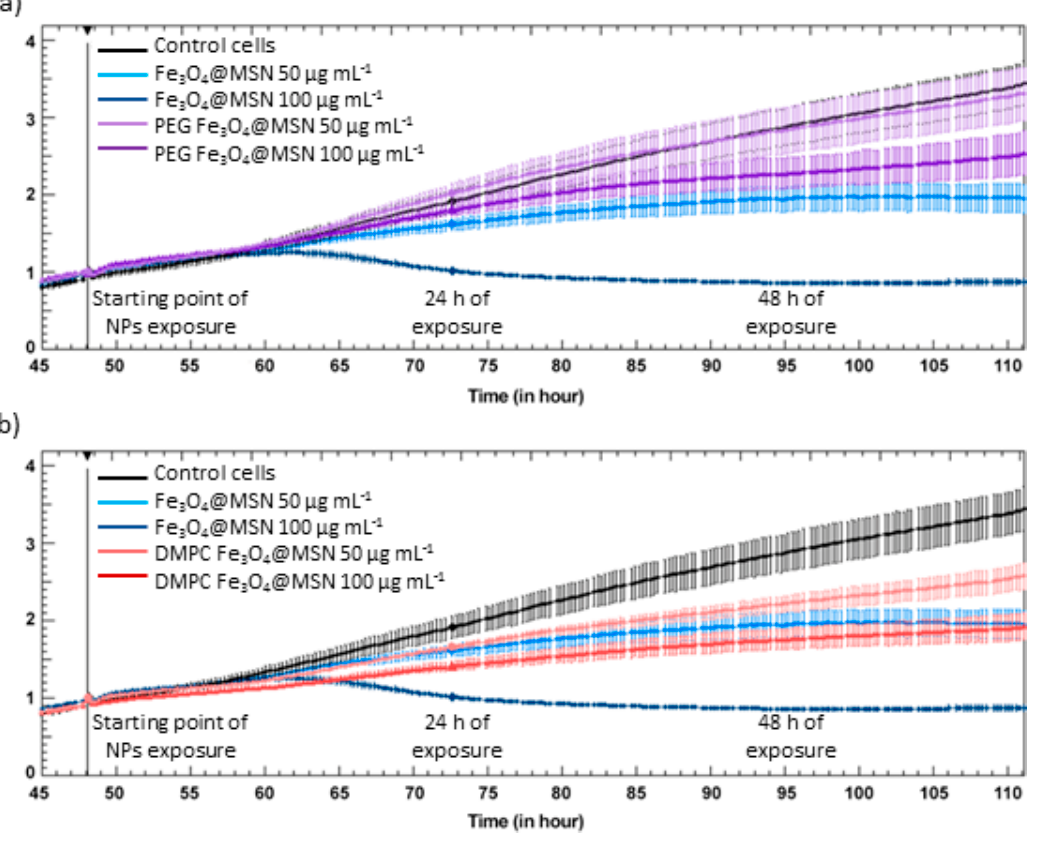
Figure 7. xCELLigence experiment. Real-time cell index (CI) monitoring of HepG2 cells ( n = 3) exposed to 50 and 100 mg mL -1 of pristine, polyethylene glycol (PEG)-coated, and dimyristoyl phosphatidylcholine (DMPC)-coated Fe 3 O 4 @MSN. ( a ) Pristine Fe 3 O 4 @MSN versus PEG-coated Fe 3 O 4 @MSN. ( b ) Pristine Fe 3 O 4 @MSN versus DMPC-coated Fe 3 O 4 @MSN. Reproduced and adapted from Nyalosaso et al. 2016 [3] with permission from the Royal Society of